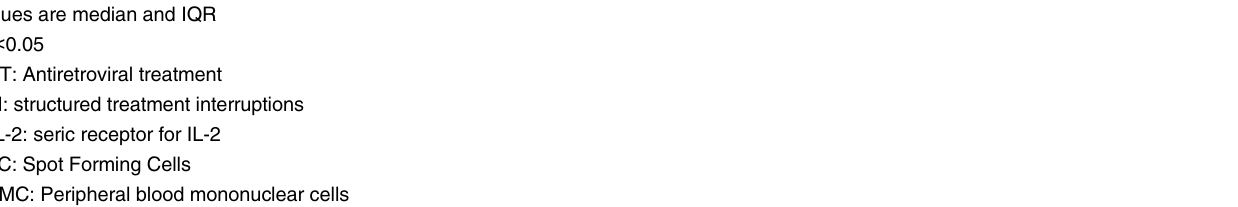
Overall injections were well tolerated, but all patients presented mild injection-site reactions. One patient presented cellulitis. No adverse effects on liver tests, red blood cells, white blood cells or lipid profile were seen (data not shown).